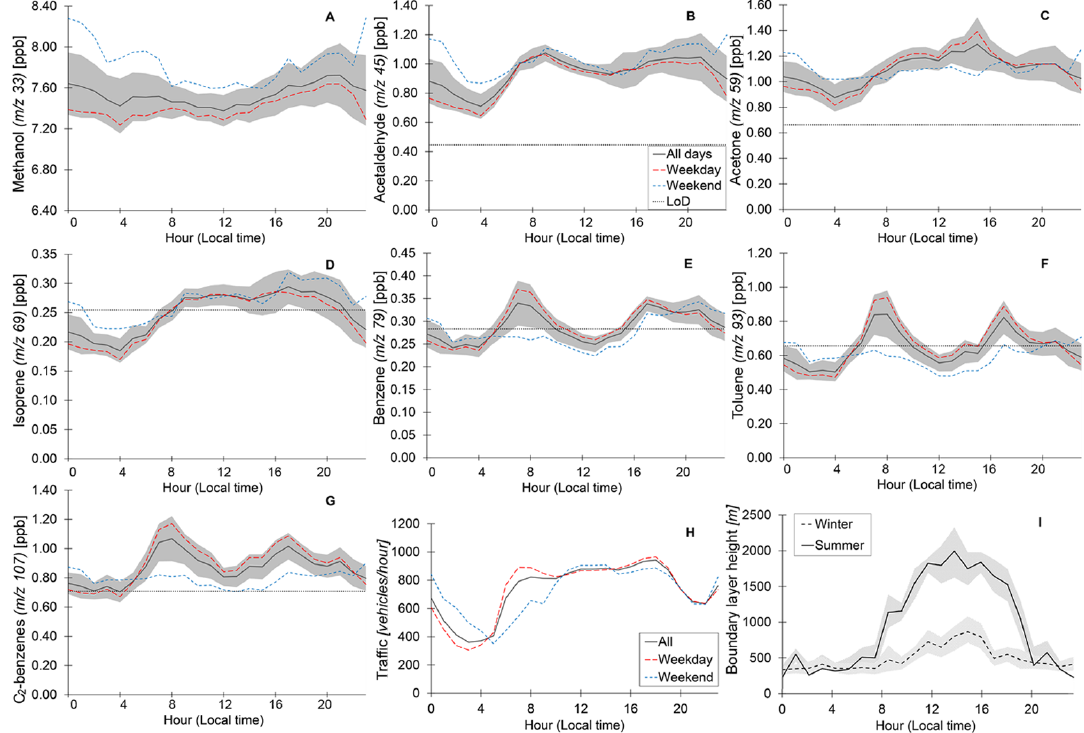
Figure 2. Part 1: average diurnal profiles in local time for selected VOC fluxes (mgm − 2 h − 1 ) separated into all days, weekdays (red dashed line) and weekends (blue dotted line) with traffic density (vehiclesh − 1 ), detection limit (patterned area) and upper and lower confidence intervals (shaded area). Traffic density (with weekday and weekend) and boundary layer mixing height (for summer and winter) are shown in separate panels. Compounds are m/z 33 (methanol), m/z 45 (acetaldehyde), m/z 59 (acetone/propanal), m/z 69 (isoprene/furan), m/z 79 (benzene), m/z 93 (toluene) and m/z 107 (C 2 -benzenes). Part 2: average diurnal profiles in local time for selected VOC mixing ratios (ppb) separated into all days, weekdays (red dashed line) and weekends (blue dotted line) with detection limit (dotted line) and upper and lower confidence intervals (shaded area). Traffic density (with weekday and weekend) and boundary layer mixing height (for summer and winter) are shown in separate panels. Compounds are m/z 33 (methanol), m/z 45 (acetaldehyde), m/z 59 (acetone/propanal), m/z 69 (isoprene/furan), m/z 79 (benzene), m/z 93 (toluene) and m/z 107 (C 2 -benzenes). The mixing ratio axes start from 0 apart from that of methanol, which begins at 6.4ppb due to the high atmospheric